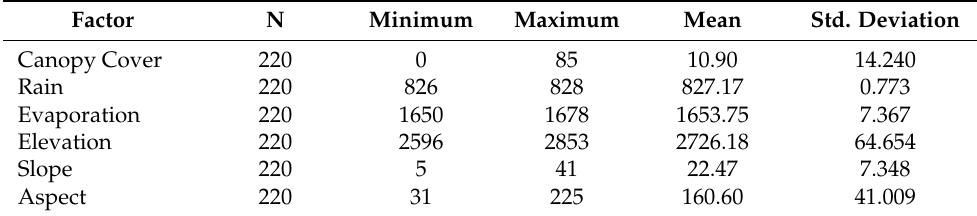
Table 1. Descriptive statistics of research